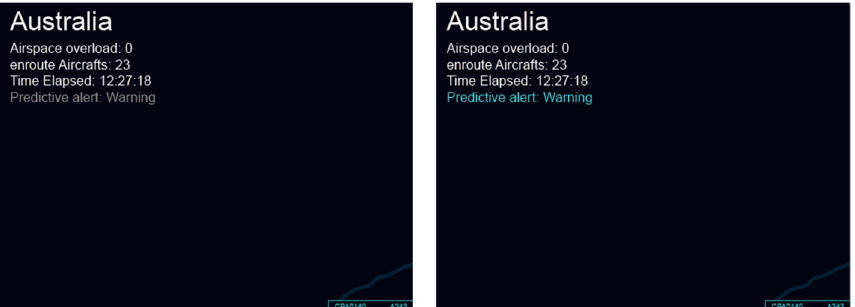
Figure 18. Visual interaction in prompt mode at the top left corner.